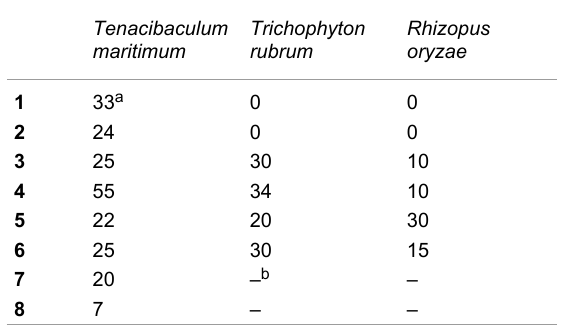
Table 2: Antimicrobial activity of 1 – 8 evaluated at 10 μ g on Ø 6 mm-paper